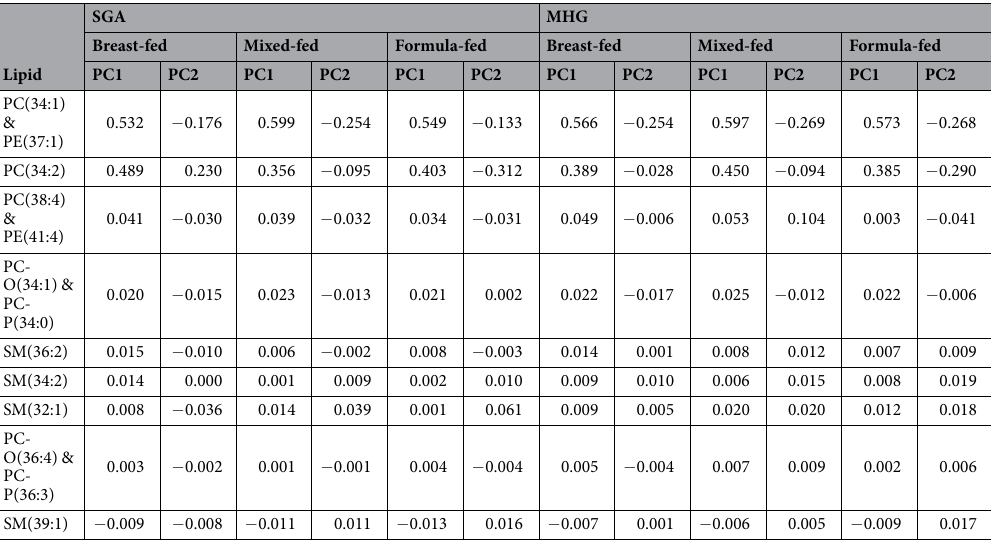
Table 1. Loading values for candidate biomarkers. Loading values generated by PCAs for the candidate biomarkers identified by sPLS-DA. Each exposed group ( e.g. SGA-breastfed) tested against the appropriate control group ( e.g. Control-breastfed). Loading values reflect the ranking of the variables by the (unsupervised) test. Note that the quantified rankings are only valid within principal components and thus cannot be compared between the groups. This test indicated that similar variables to those identified in Fig. 2 were important.